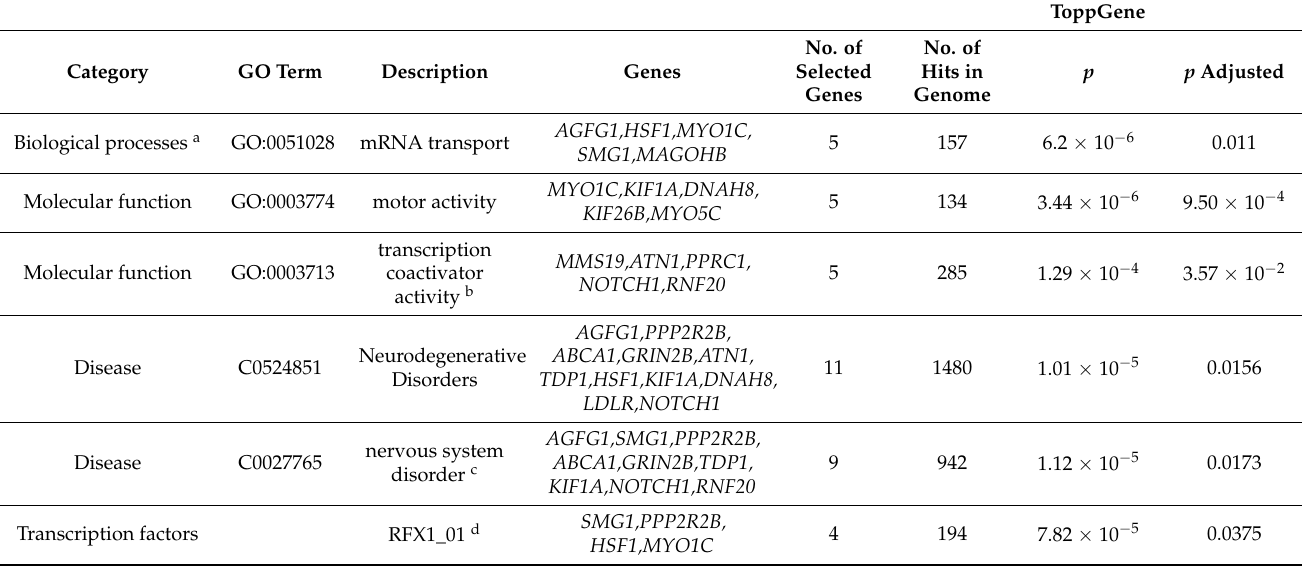
Table 3. Enrichment analysis. The table shows the results obtained using ToppGene